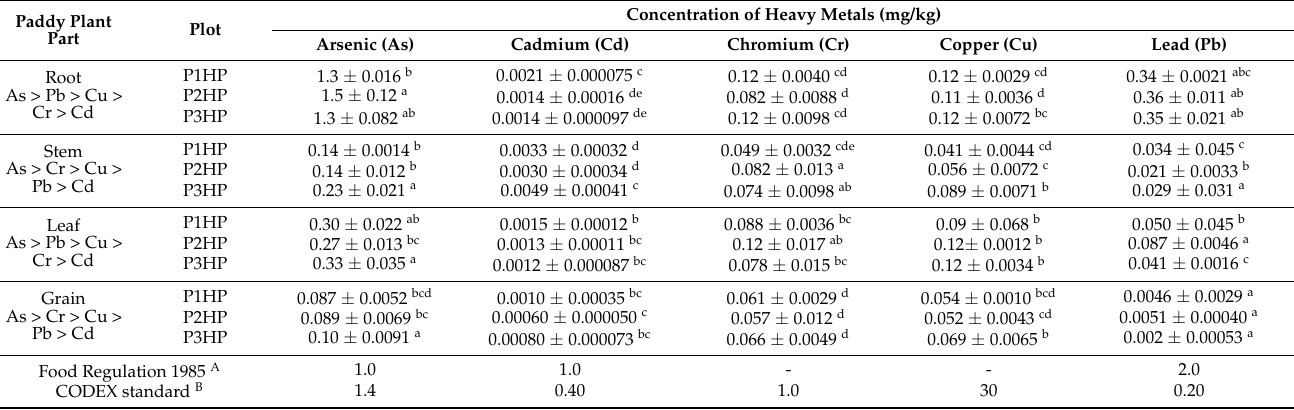
Table 4. Concentration of heavy metals in paddy plants collected from Hilir